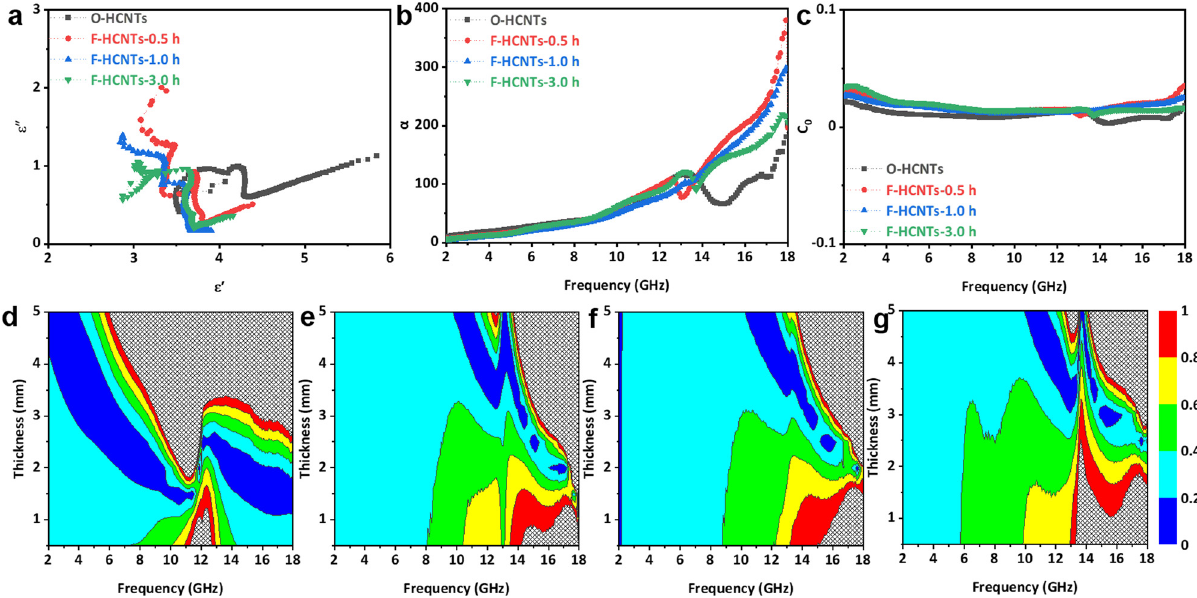
Figure 5: Analysis of the electromagnetic parameters: ( a ) Cole – Cole curves, ( b ) attenuation factors, ( c ) C 0 , and ( d – f ) the impedance matching degree of O - HCNTs, F - HCNTs - 0.5 h, F - HCNTs - 1.0 h, and F - HCNTs - 3.0 h,